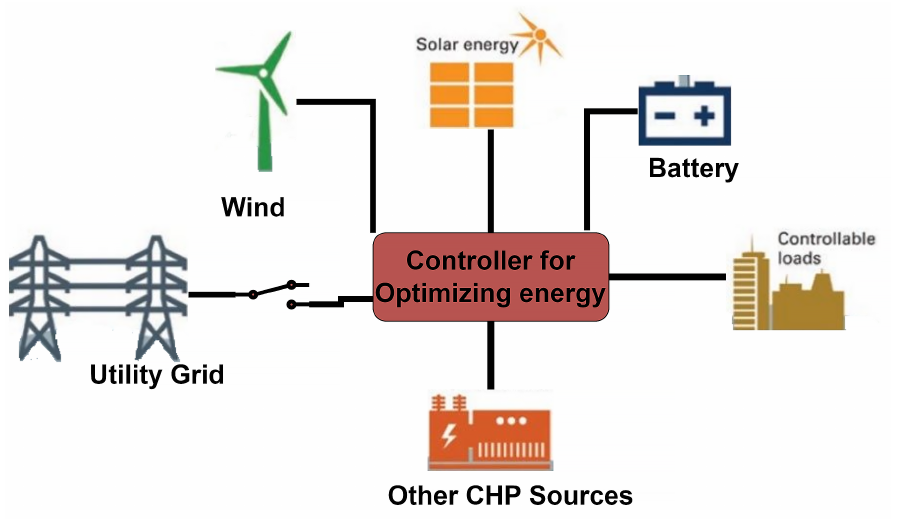
Figure 1. Smart microgrid with solar PV and wind as